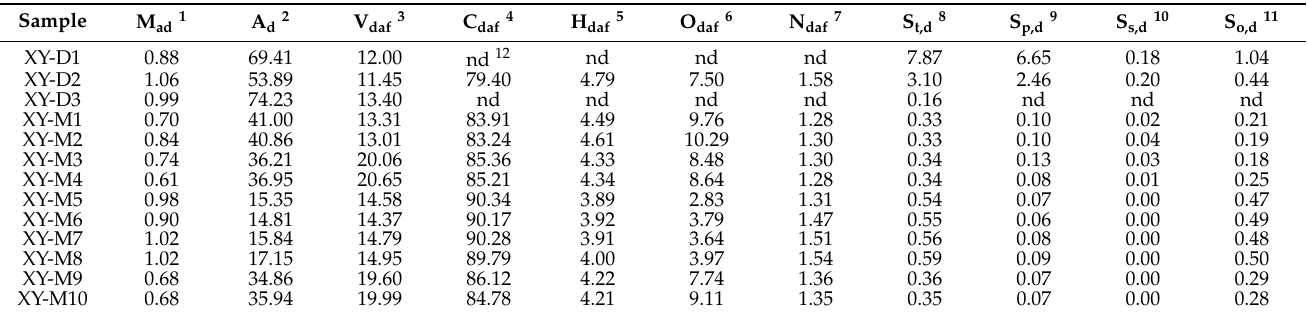
Table 1. Proximate and ultimate analysis and sulfur contents of the No. 9 coal and related roof samples from the Xinyuan mine (%)